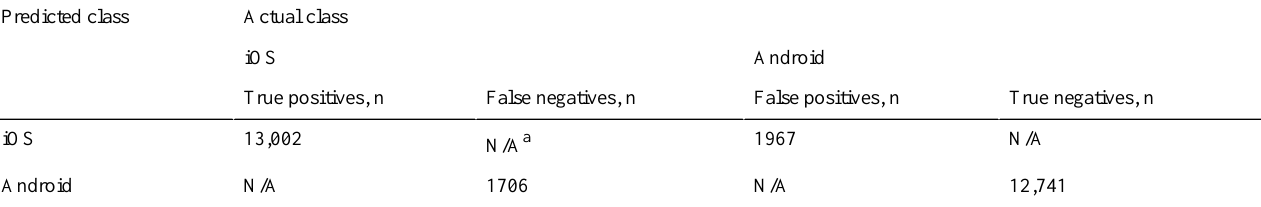
Table 6. Confusion table for the support vector machine (SVM) calculations over all eight dynamic ecological momentary assessment (EMA-D)